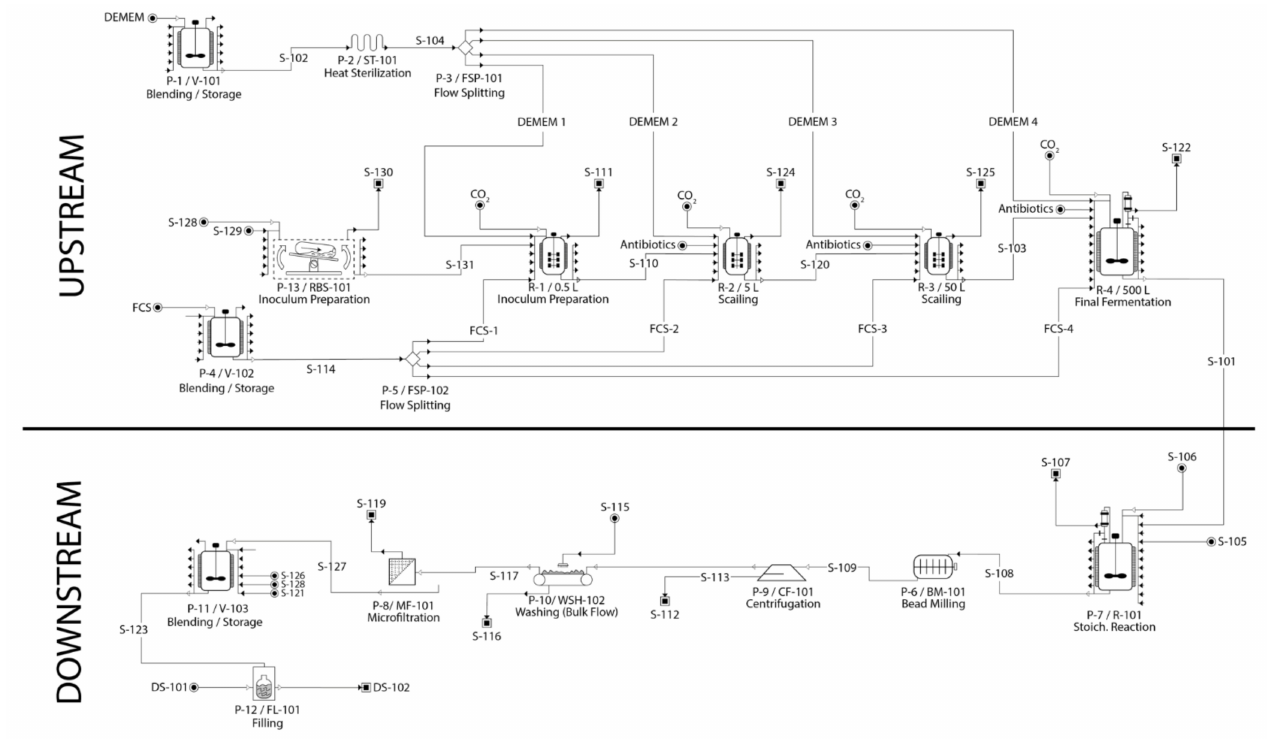
Figure 2. Flow diagram of the production, procurement, and purification process of influenza